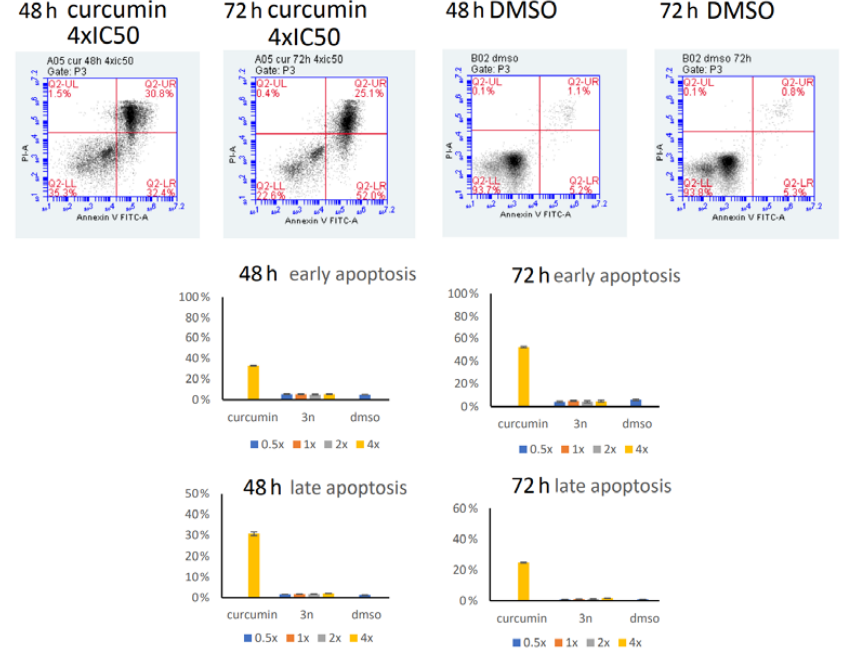
Figure 9. Induction of apoptosis in CCRF ‐ CEM cells upon exposure at 37 °C for 48 or 72 h with N ‐ (3 ‐ nitrophenylpyrazole) curcumin as determined by the annexin V/propidium iodide assay and flow cytometry. Cells were incubated with 0.5×, 1×, 2×, or 4× IC 50 N ‐ (3 ‐ nitrophenylpyrazole) curcumin. Positive control: curcumin (4× IC 50 ); negative control: DMSO. Mean ± SD of three independent measurements.